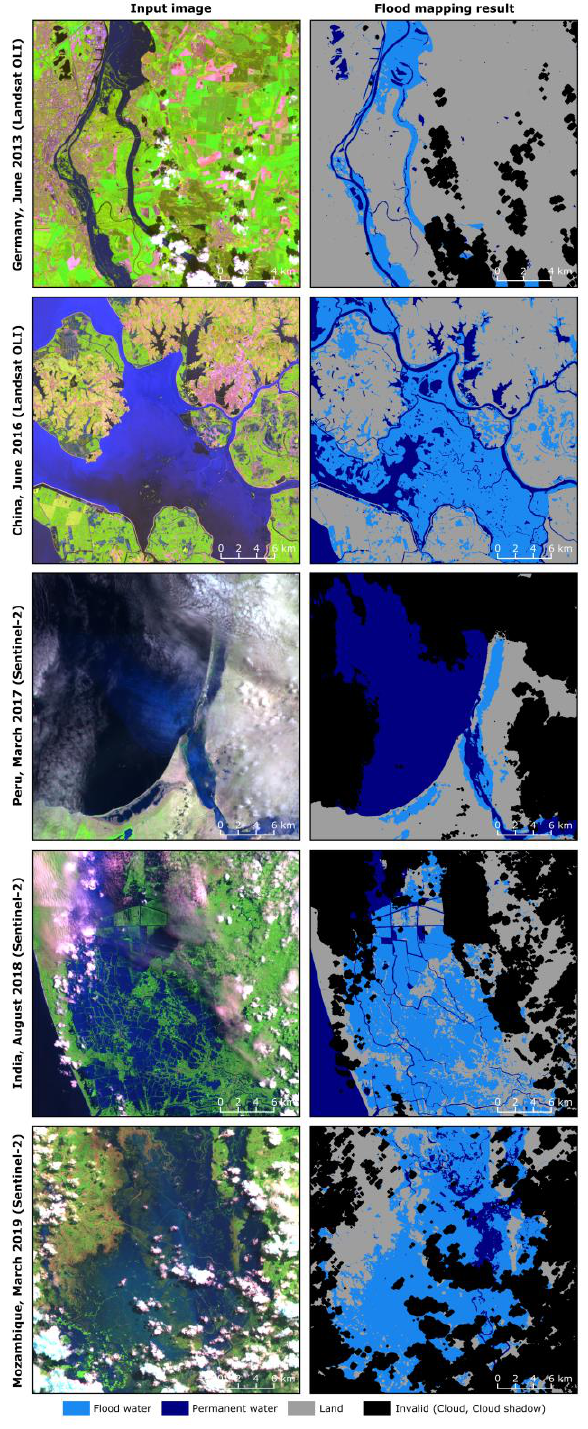
Figure 3. Test images of flood disasters with respective results of the flood mapping method.